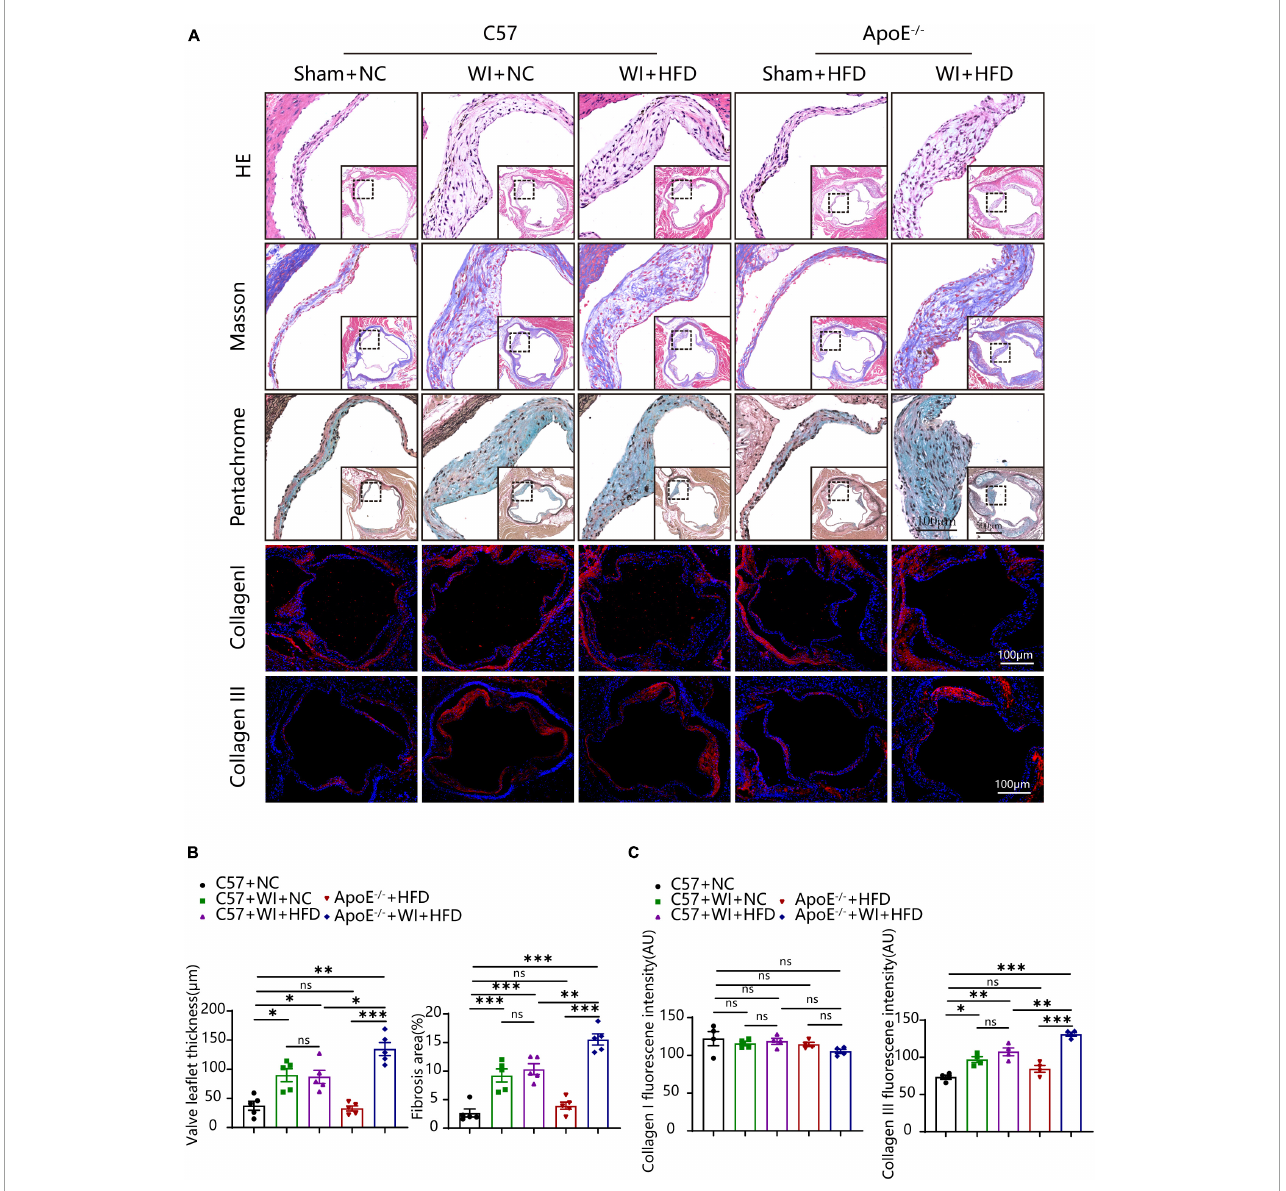
FIGURE3 Combined mechanical injury and hyperlipidemia induced advanced aortic valve pathological changes. (A) Pathological changes of murine aortic valve 8 weeks after wire injury in the indicated groups stained with HE, Masson, Pentachrome (large, scale bar, 100 µ m; small, scale bar, 500 µ m) and immunofluorescence of Collagen I and Collagen III (scale bar, 100 µ m). (B) Quantification of the valve leaflet thickness and the fibrosis area of murine aortic valve 8 weeks after wire injury in the indicated groups ( n = 5 per group). (C) Quantification of fluorescent intensity of Collagen I and Collagen III. Results are mean ± SEM. Adjusted P values were provided in case of multiple groups. ns. indicates non-significant P value. * P < 0.05, ** P < 0.01, and *** P <